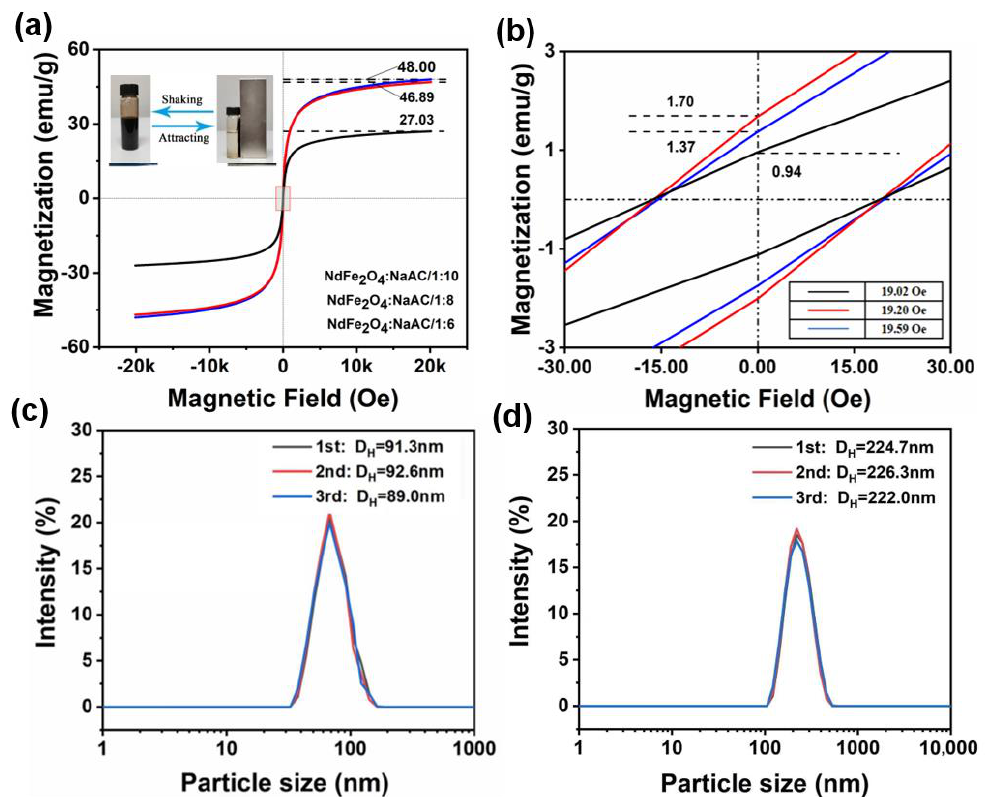
Figure 5. Magnetic performance of NdFe 2 O 4 NPs. ( a ) M−H curves; ( b ) enlarged M−H curves; DLS data at 1:6 ( c ), and 1:10 ( d ) of NdFe 2 O 4 NPs.